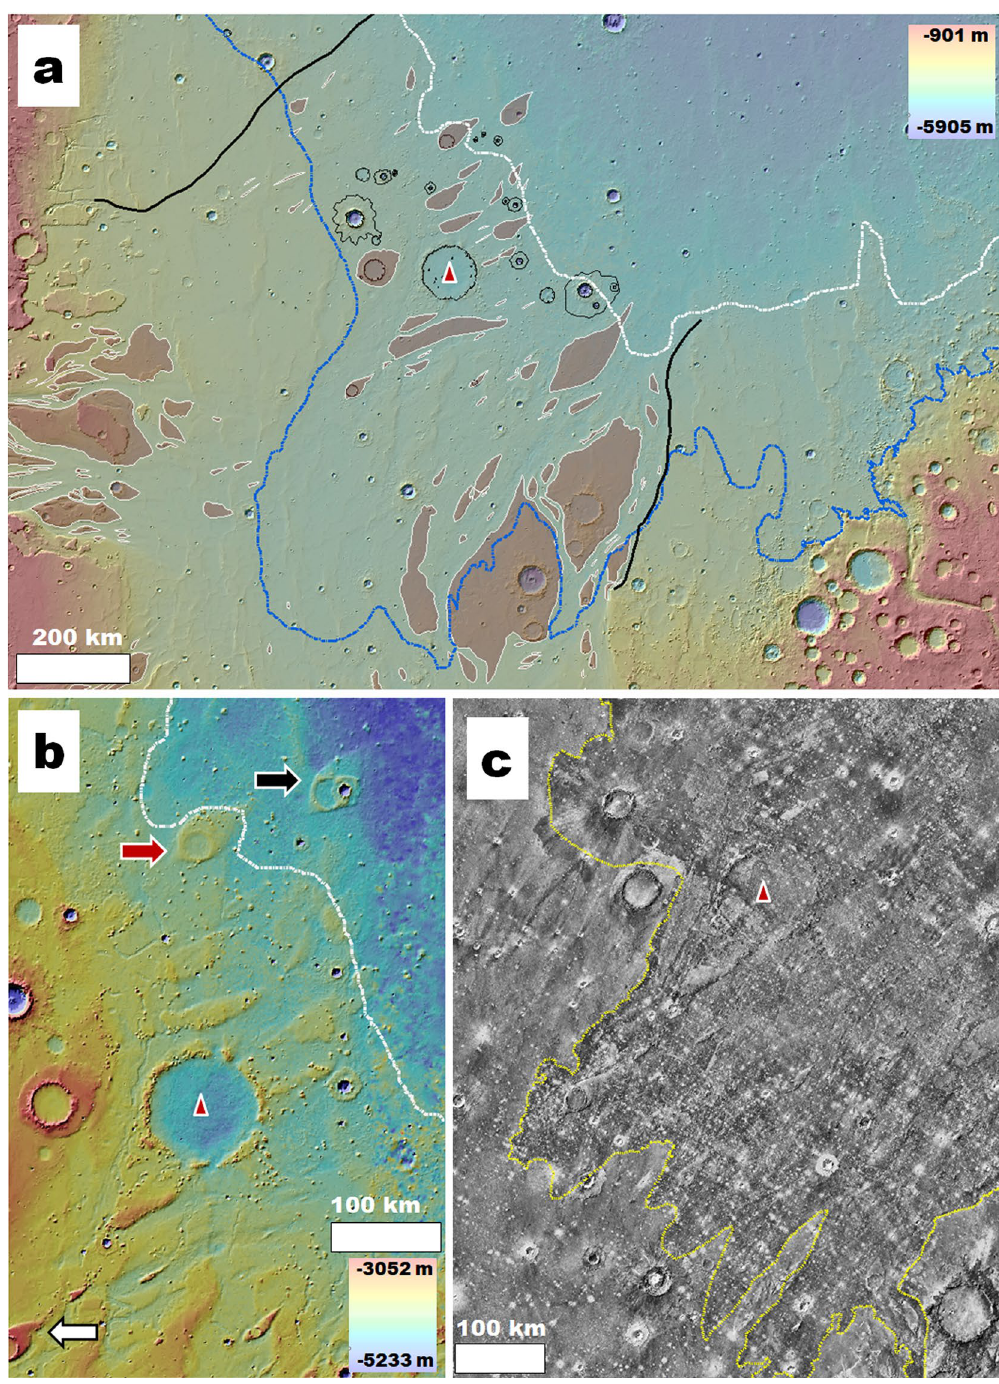
Figure 2. Physiographic and geologic setting of Pohl. In each panel, the crater’s center is indicated by a red triangle. (a) View of Chryse Planitia showing widespread streamlined features (shaded brown) produced by catastrophic flooding into the northern plains. The black lines delineate the approximate lateral extents of these fluvial terrains. The white and blue dashed lines delineate the lower (− 4100 m) and upper (− 3800 m) paleoshoreline stands mapped by Rodriguez, et al. 6 . The lower of these, ~ 130 km northeast from Pohl, marks the abrupt termination of the region’s catastrophic flood surface features. Combined color and shaded-relief MOLA DEMs (460 m per pixel, credit: MOLA Science Team, MSS, JPL, NASA). (b) Close-up view of Pohl showing that it forms a significant discontinuity of the regionally scoured landscapes’ topography. The black and white arrows identify streamlined features downstream and upstream from Pohl. The white dashed line traces the lower shoreline (~ − 4100 m) mapped by Rodriguez, et al. 6 . The red arrow identifies the streamlined island shown in Fig. S3c. Combined color and shaded-relief MOLA DEMs (460 m per pixel, credit: MOLA Science Team, MSS, JPL, NASA). (c) View showing the younger megatsunami deposit regional upper reaches covering and embaying Pohl (unit member lHl 2 in Rodriguez, et al. 6 ). The deposit’s surface appears dark in this nighttime thermal infrared image, and a yellow dotted line delineates its upper boundary. THEMIS nighttime IR global layer (http:// www. mars. asu. edu/ data/, 100 m per pixel, credit: Christensen, et al. 7 ). We produced this figure using Esri’s ArcGIS 10.3 (http:// www. esri. com/ softw are/